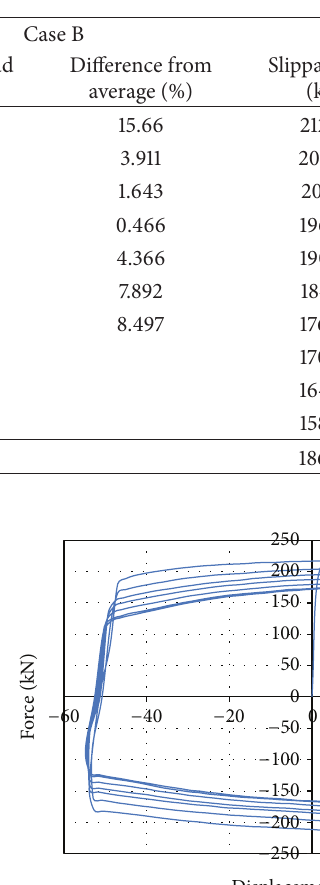
Figure 3: Connection of specimen to the actuator: (a) cylinder; (b) solid shaft. Table 2: Slippage load for each cycle of loading.